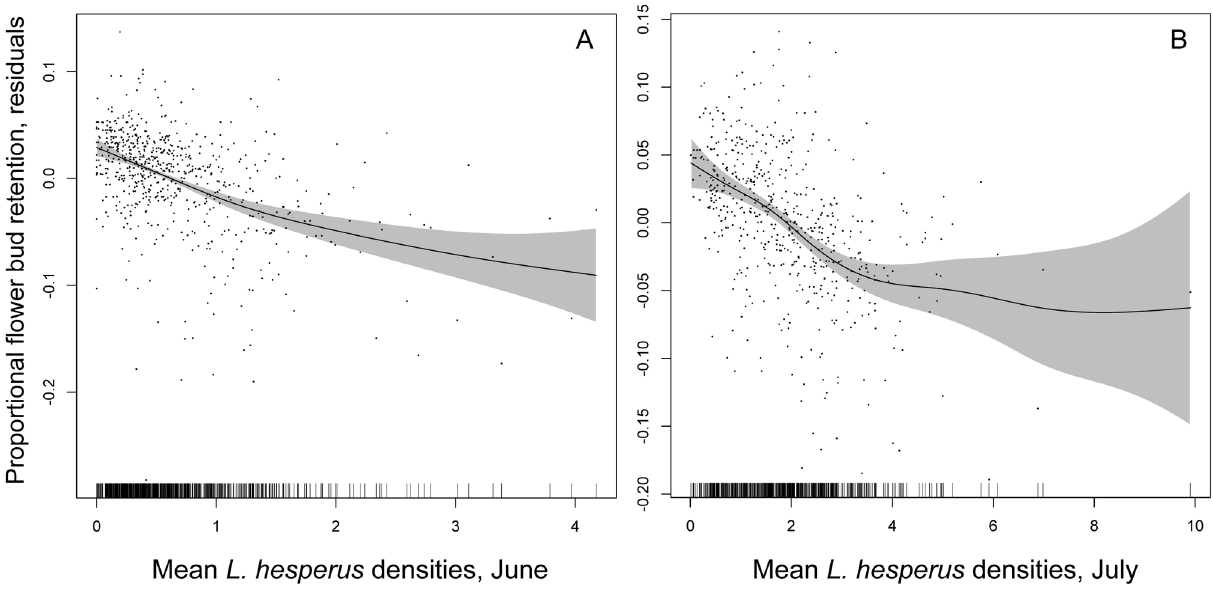
Figure 1. Flower bud retention and L . hesperus density. Association between the proportion of cotton flower buds retained and mean L . hesperus densities observed during (A) June, and (B) July. Retention values are residuals after controlling statistically for effects of farm, year, and cotton species. The solid lines are the smooths from the GAM models, and the shaded regions are the 95% confidence